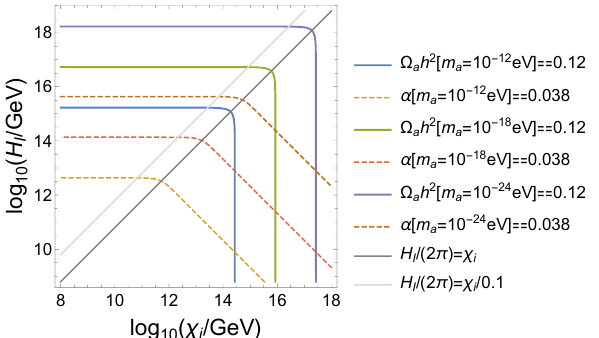
Figure 5. Constrains from dark matter abundance and isocurvature spectrum, for ALPs produc- tion in PQ broken scenario, under the assumption that ALPs began oscillation during RD epoch. The solid lines present when axion constitute all the dark matter, and the region below the line is the parameter space allowed. The dashed lines present when axion perturbations contribute all the isocurvature perturbation, and the region below is allowed. The three groups of lines are for ALPs with different masses m . PQ broken scenario requires H (2 π ) < f = χ , which is showed by a I / a i /θ i gray lines for different initial misalignment angle θ . We can see that, lighter ALPs allow higher i scale